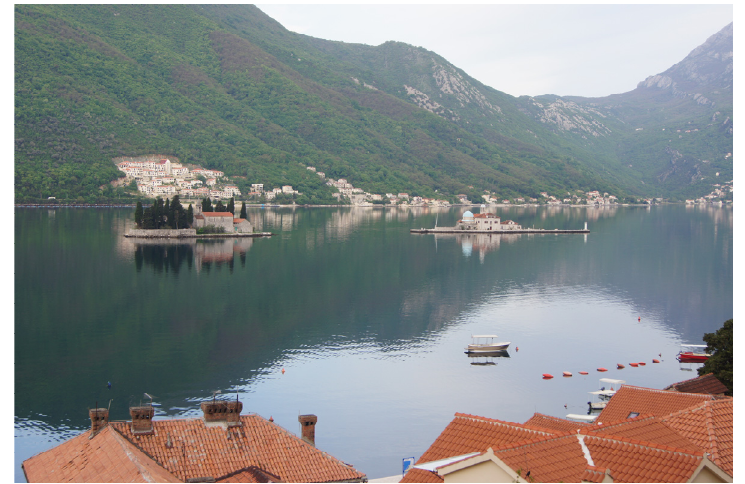
Figure 1. The two islands in 2021. Photo by the